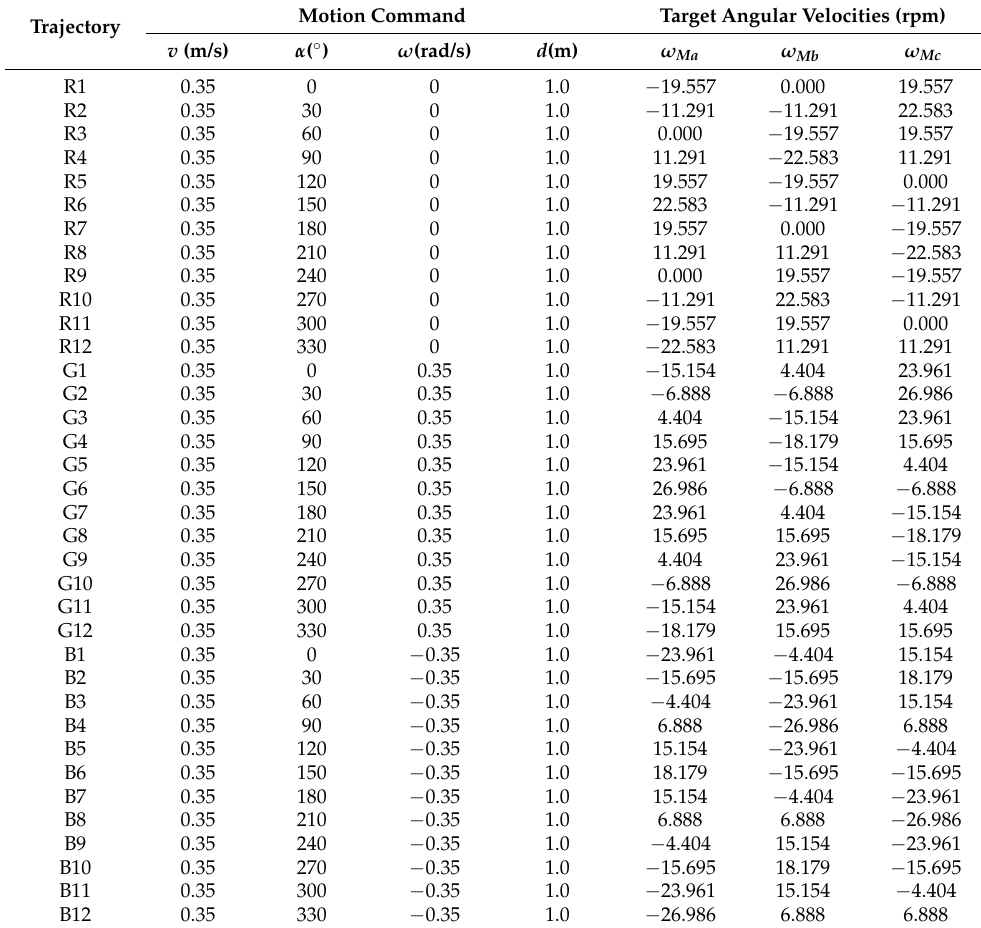
Table A1. Description of the motion commands and the corresponding target angular velocities of the wheels corresponding to the calibration trajectories shown in Figure